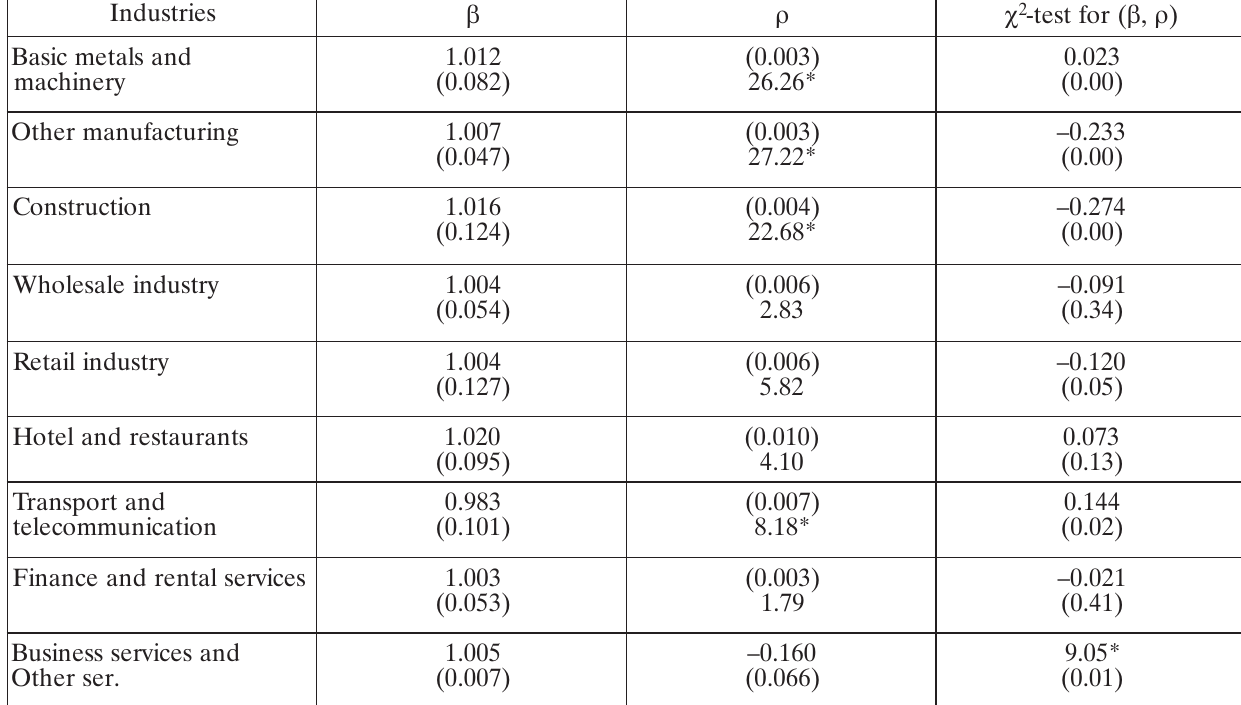
Table 3. Test statistics for (cid:4) , (cid:1) and the ( (cid:4) , (cid:1) )-restriction in the different